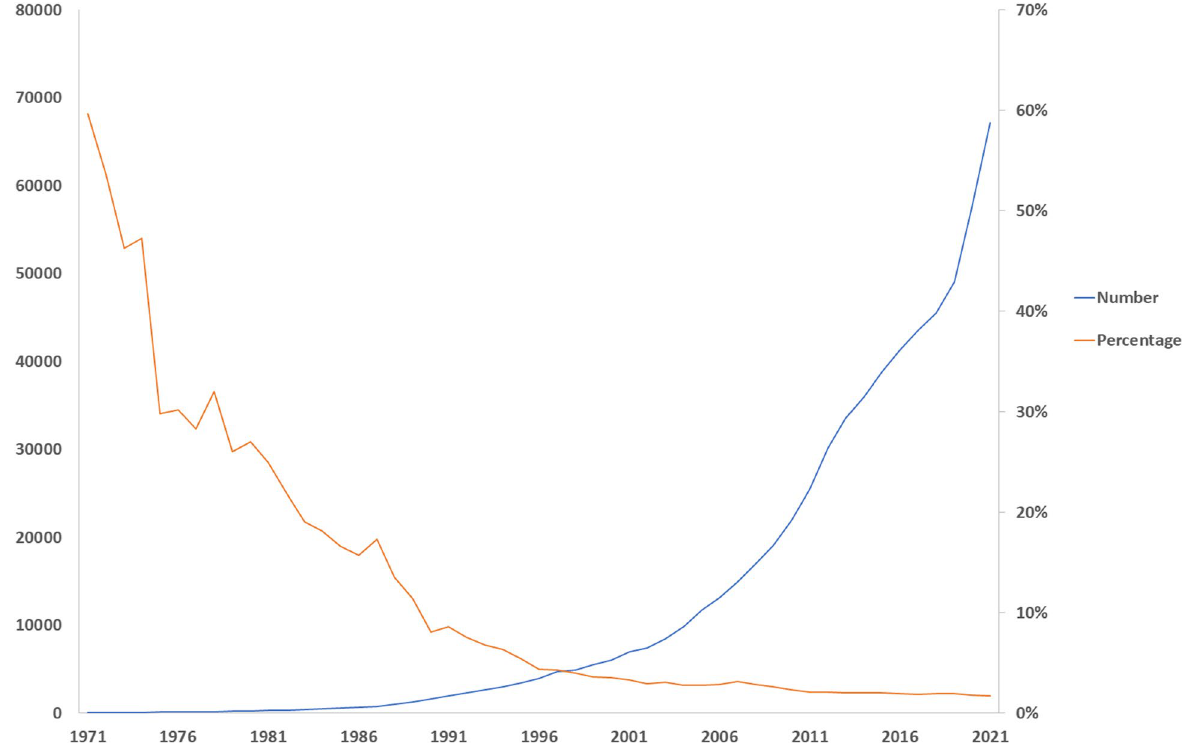
Fig. 4 Number of articles using multivariate/multivariable regression analysis and percentage of those declaring this method in the